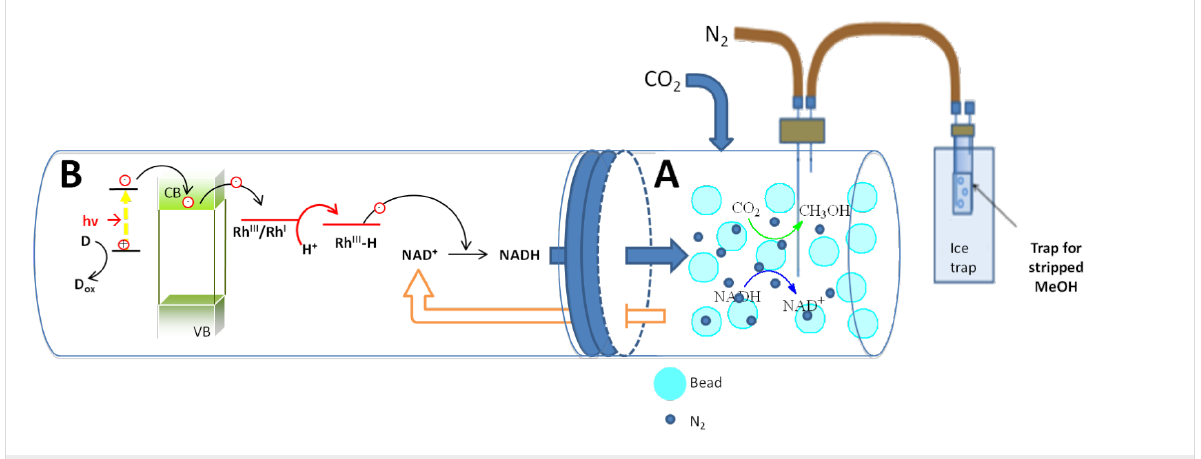
Figure 13: Assembled photocatalytic/enzymatic system for reduction of CO 2 to CH 3 OH.